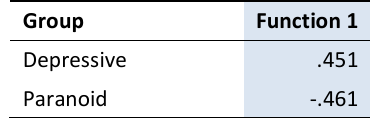
Table 11: Group centroids on the discriminant